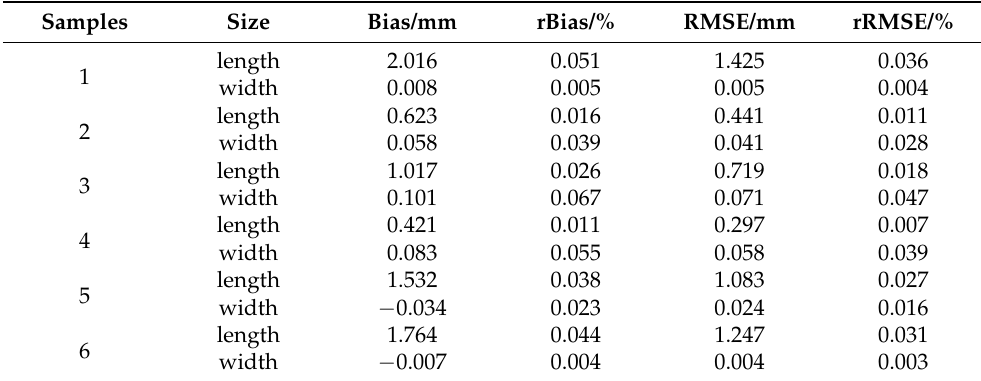
Table 4. The error analysis of the dimensional measurement of the